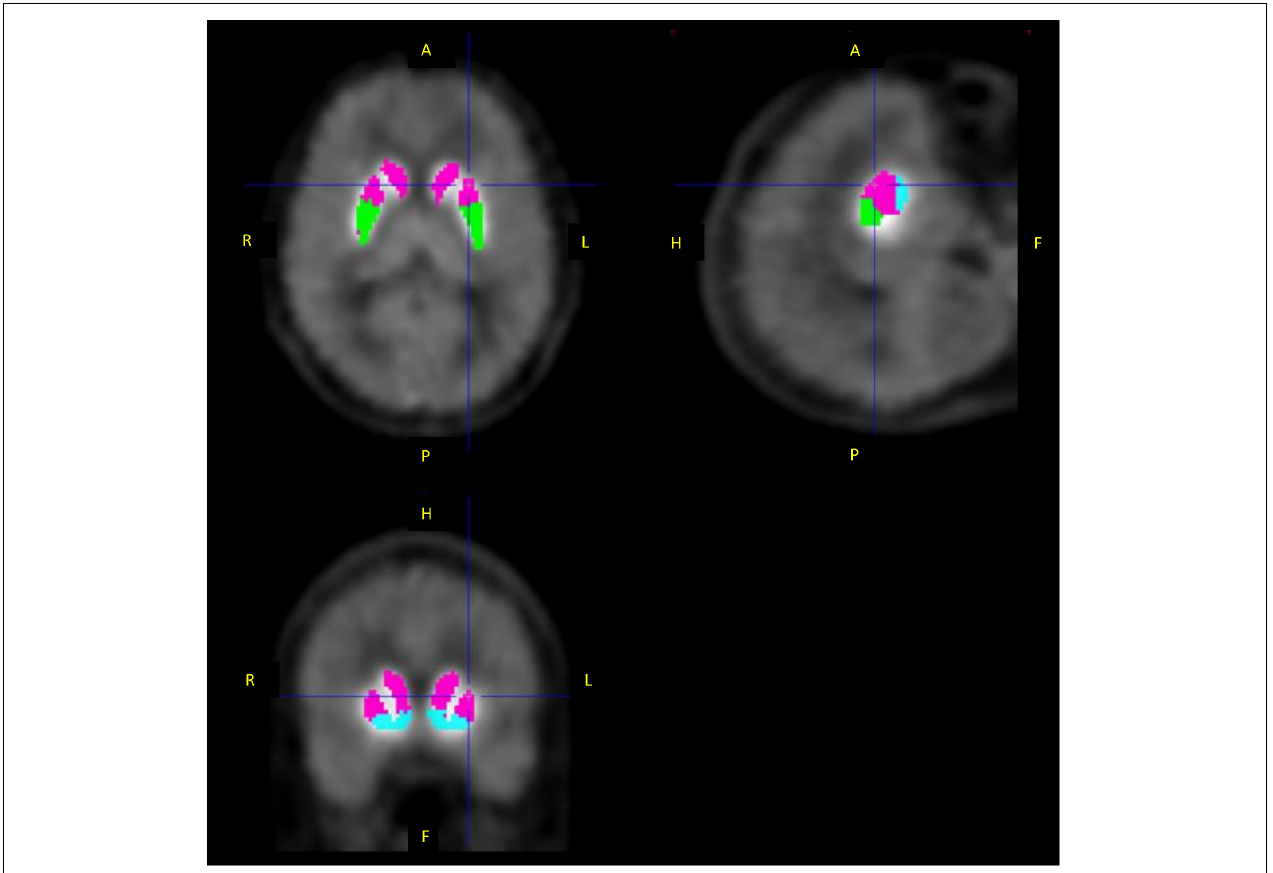
FIGURE 3 | Regions of interest for the limbic striatum (blue), executive striatum (pink), and sensorimotor striatum